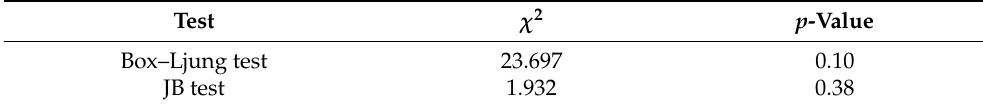
Table 10. The results of the Box–Ljung and Q-statistics tests.